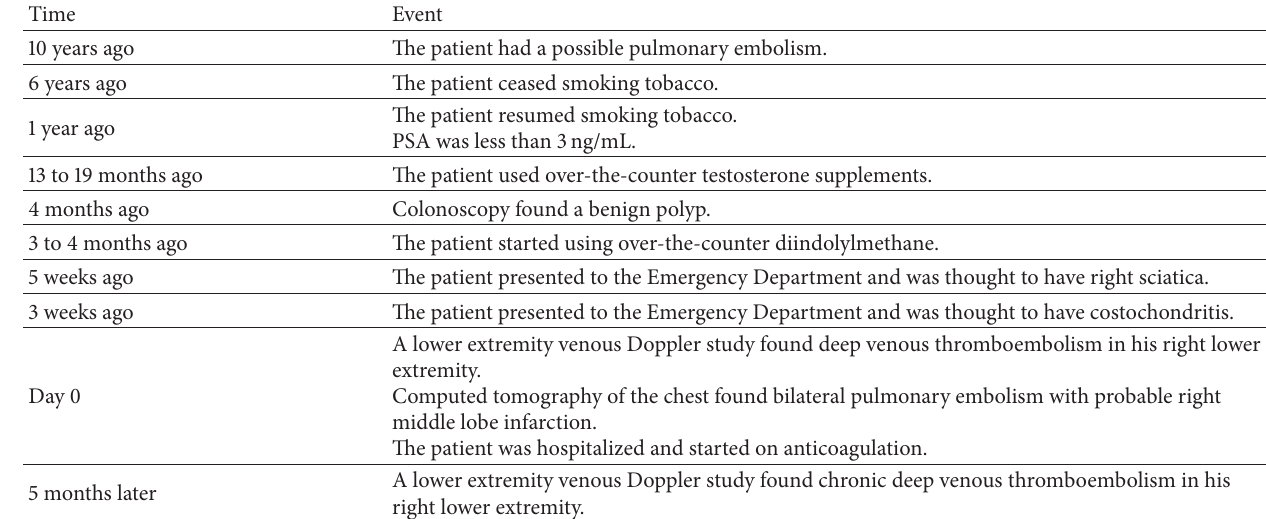
Table 1: Timeline of